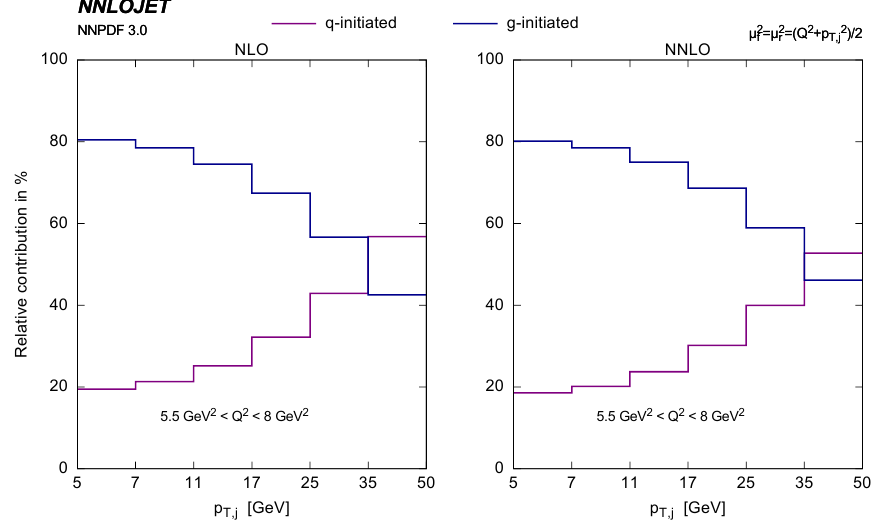
Figure 3 . Quark and gluon initiated contributions to the inclusive jet transverse momentum distribution at NLO and